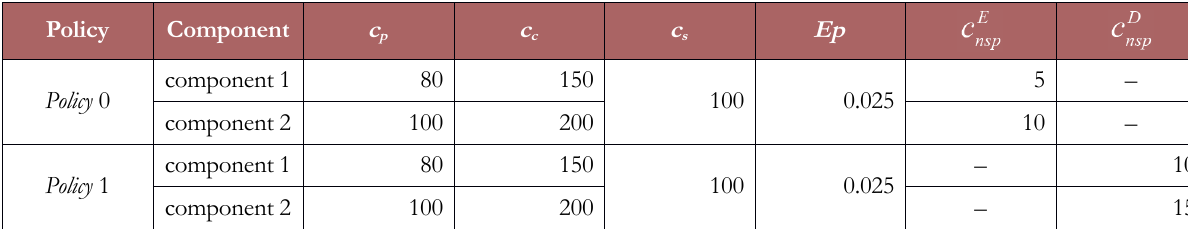
Table 2. Data of various cost parameters